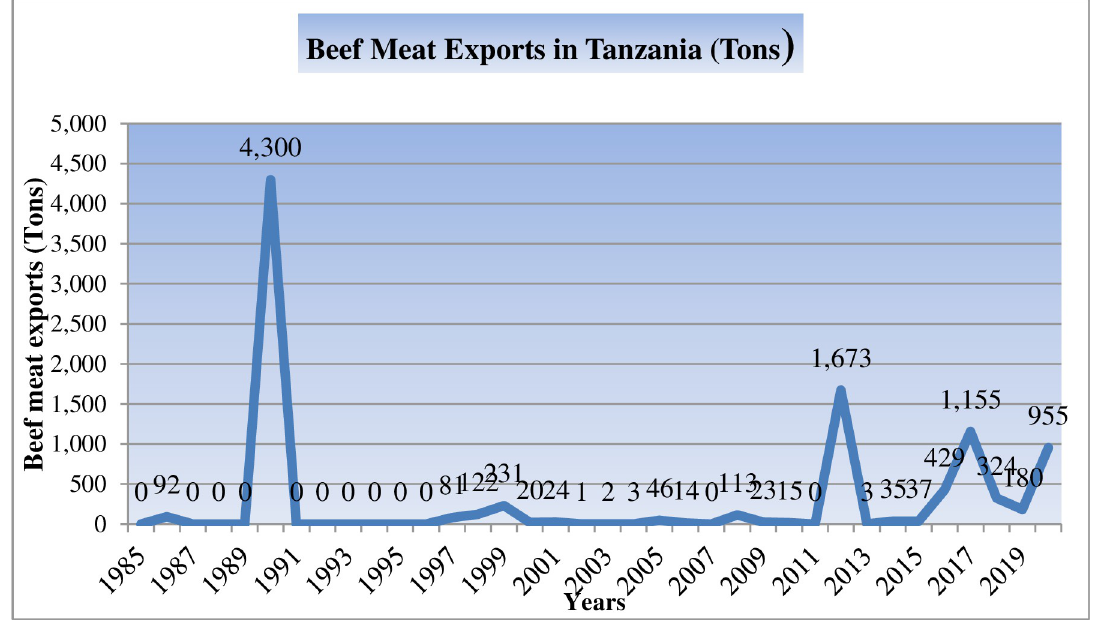
Fig 2. Trends of beef meat exports in Tanzania from 1985 to 2020 [25].